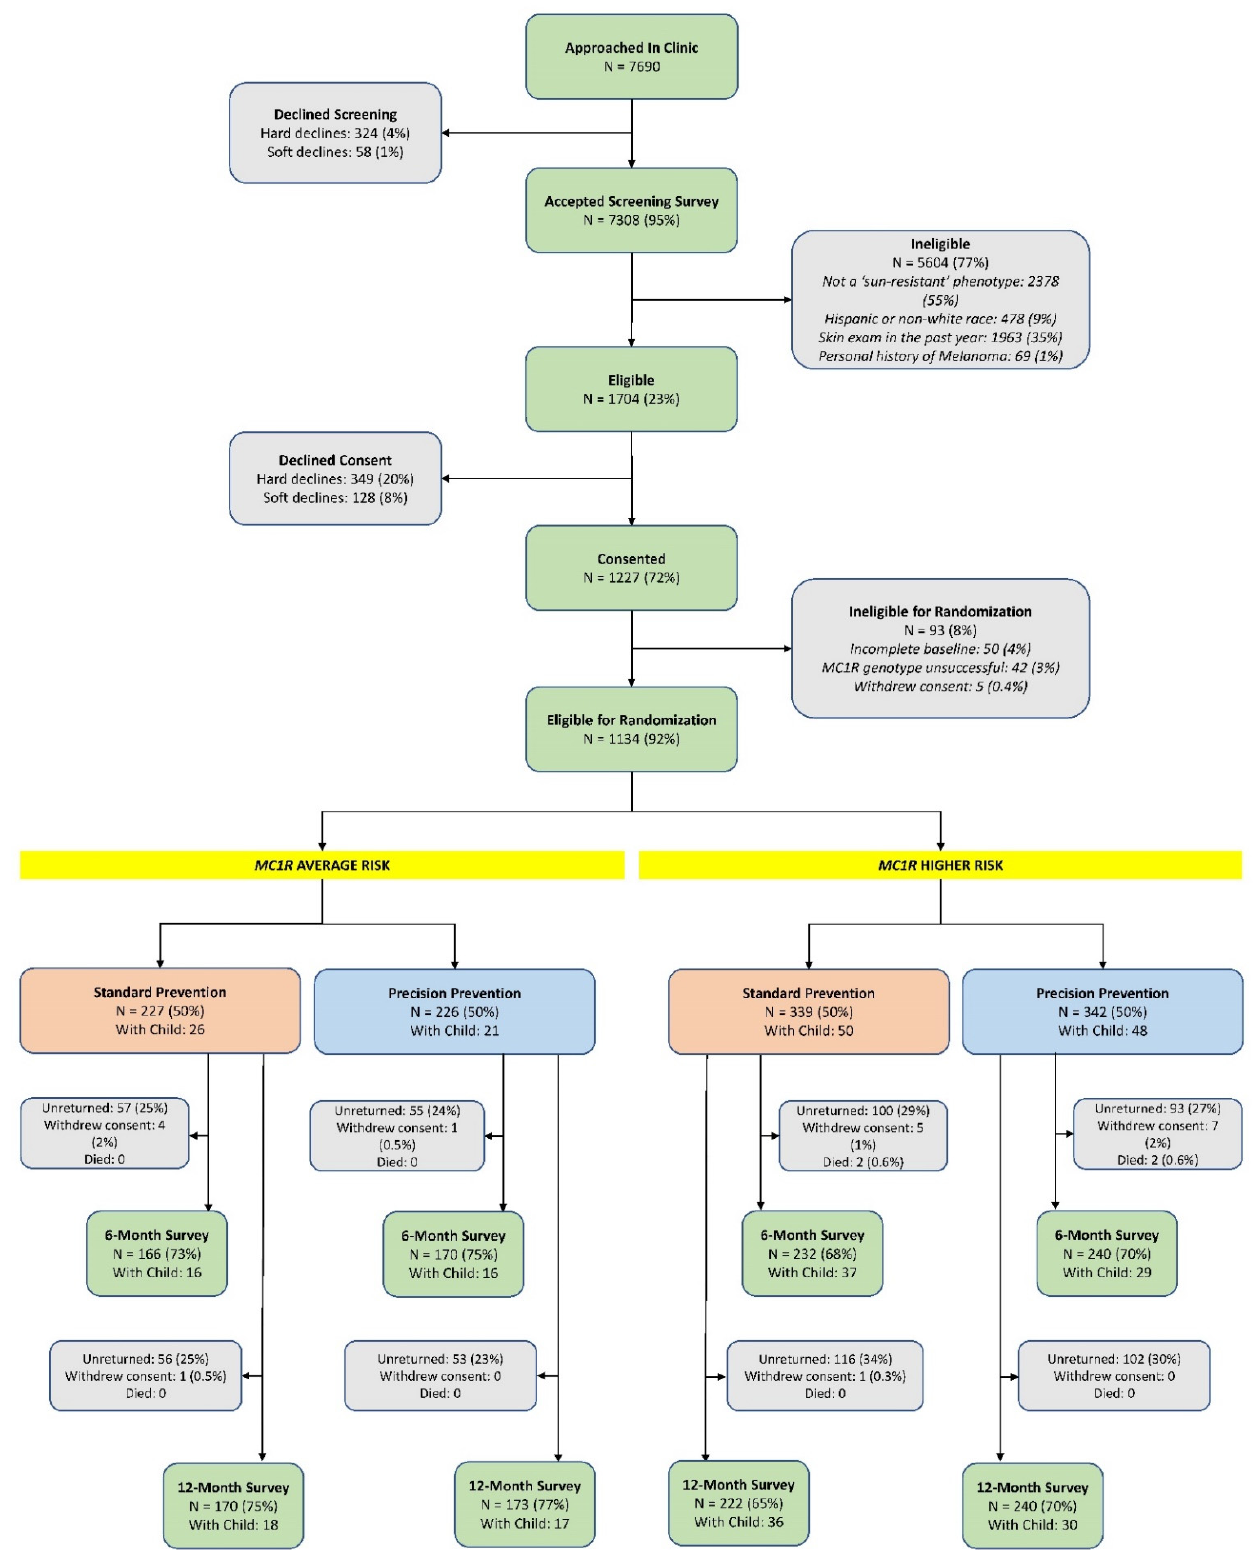
Figure 1. Flow diagram of the parallel randomized intervention trial.